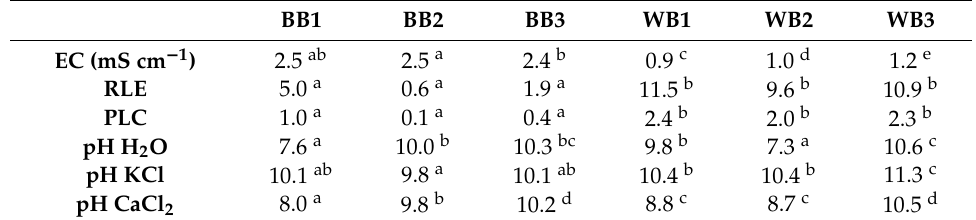
Table 5. Electrical conductivity (EC), relative liming e ff ect (RLE), potential liming capacity (PLC) and pH analysis of bamboo biochar (BB) and pinewood biochar (WB)